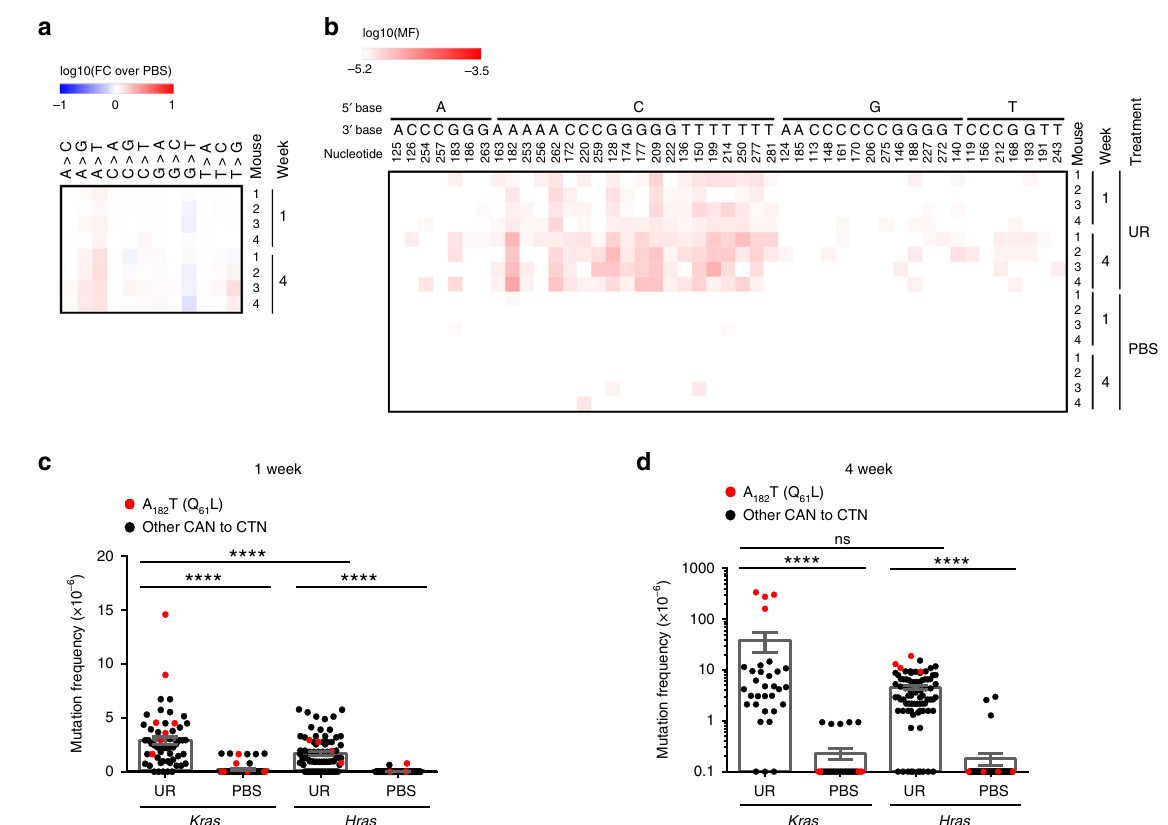
Fig. 3 MDS detects the isoform tropism of urethane. a , b Heatmap of the mutation frequency (MF) determined by MDS for the non-transcribed strand of exon 2 of Hras from the lungs of mice at the indicated time points after exposure to urethane (UR) or PBS ( n = 4 mice at each time point from one experiment), plotted as the ( a ) log-transformed fold-change normalized to PBS-treated mice (FC over PBS) or ( b ) log-transformed versus each ( a ) type of substitution or ( b ) A>T transversions (nucleotide number as well as the 5 ʹ and 3 ʹ base of the substituted A are shown at the top). c , d Mean± SEM mutation frequency of each possible CAN to CTN transversion in exon 2 of Hras ( n = 4 mice from one experiment) compared with the previous determined mutation frequency in exon 2 of Kras (Fig. 1, n = 7 mice at week 1 and 4 mice at week 4 from one experiment) at ( c ) 1 week or ( d ) 4 weeks after exposure to urethane (UR) or PBS. p values calculated by c Holm-Sidak multiple comparisons test following one-way ANOVA, or d Dunn ’ s multiple comparison test following Kruskal – Wallis test. **** p < 0.0001 and ns: not signi fi cant.